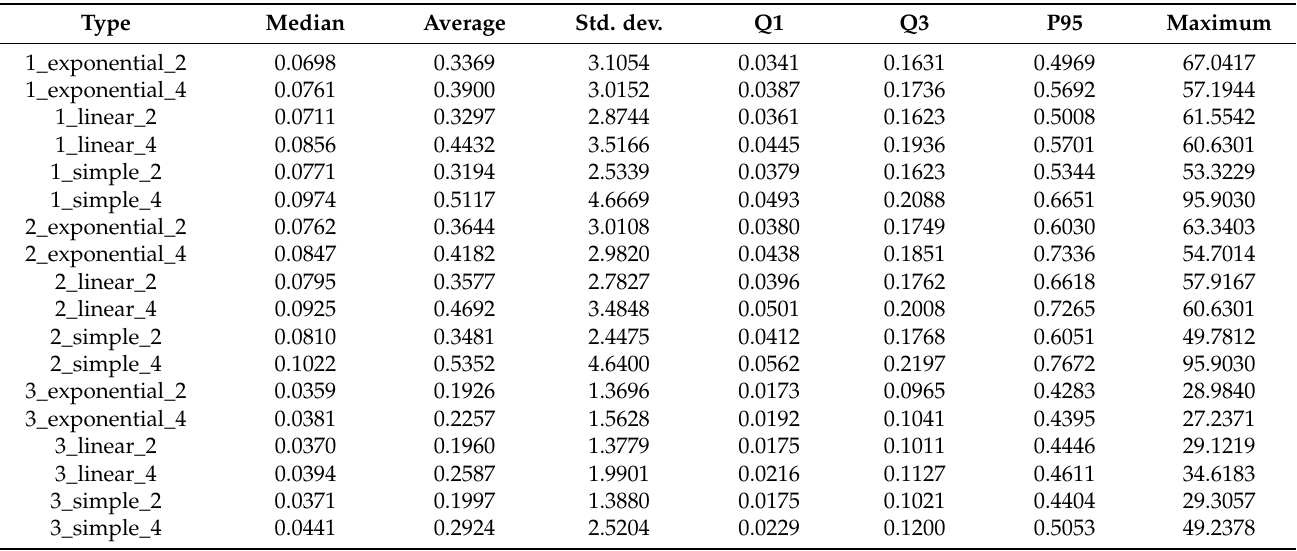
Table 4. MAPE statistics for the third set of missing data (3—from the